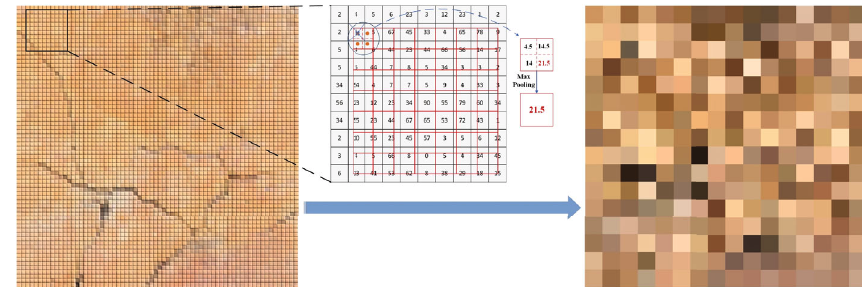
Figure 10: Feature map extraction using RoI